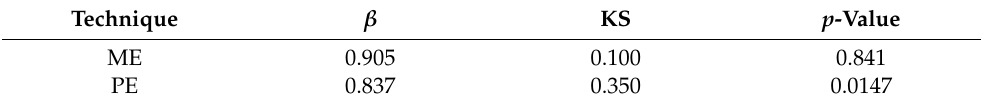
Table 12 . Di⁄erent estimators for LR data. Table 12. Different estimators for LR data.